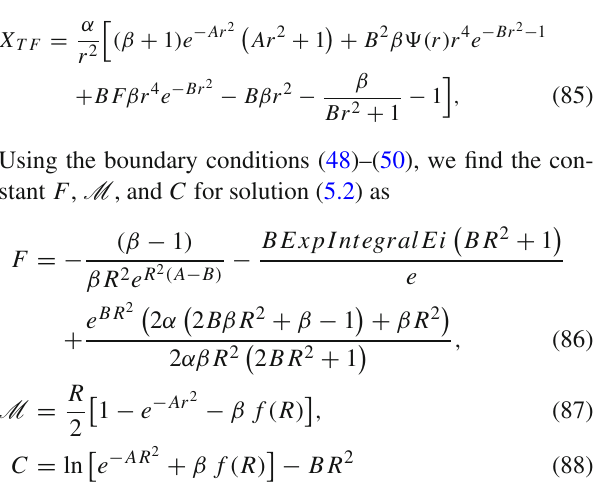
Fig. 5 Top panels : The trend of energy density ( ρ eff × 10 4 ) and radial pressure ( p eff r × 10 4 ) against the radial parameter r for different values of β . Bottom panels : The trend of tangential pressure ( p eff t × 10 4 ) and anisotropy ((cid:13) eff × 10 4 ) against radial parameter r are shown in above